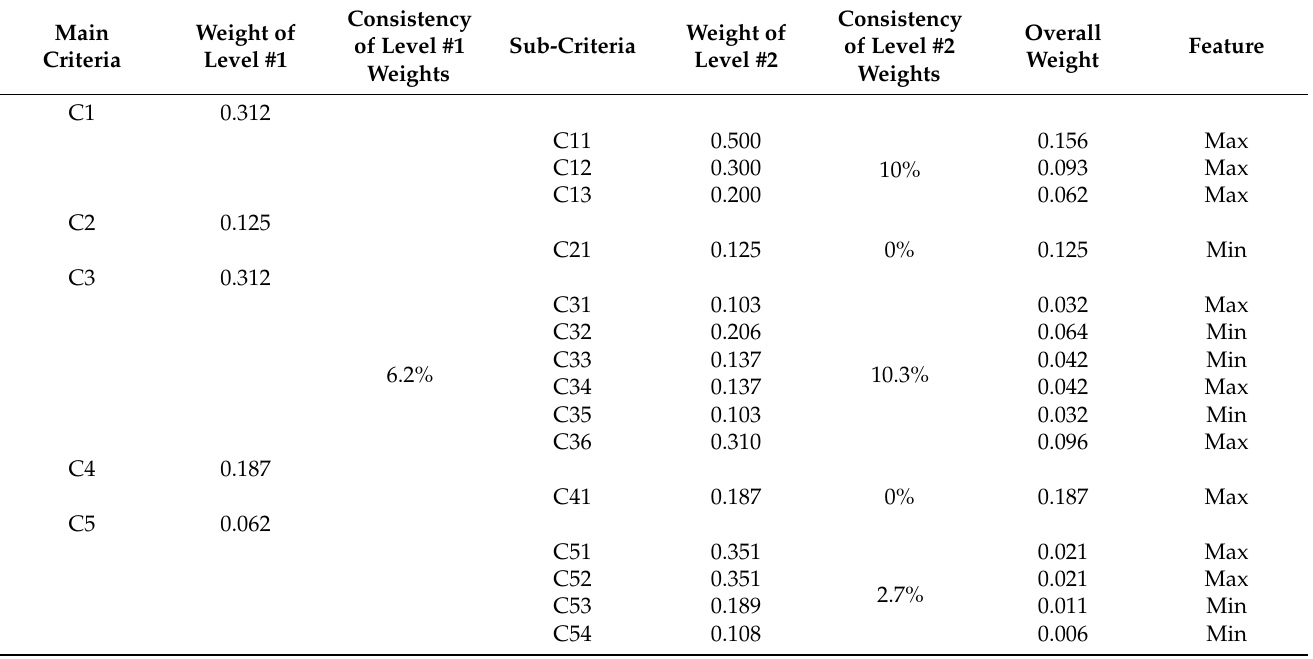
Table 6. Overview of criteria and sub-criteria